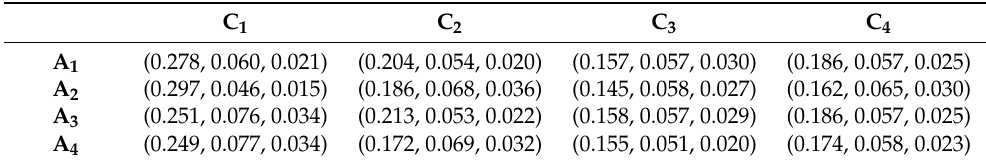
Table 8. Aggregated weighted neutrosophic decision